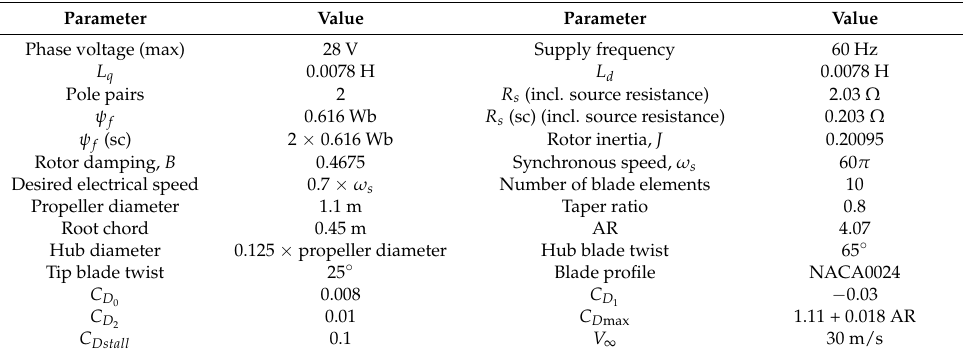
Table 1. Assumed parameters of a permanent magnet synchronous motor (PMSM)-propeller system. (The parameters corresponding to a superconducting temperature are indicated by